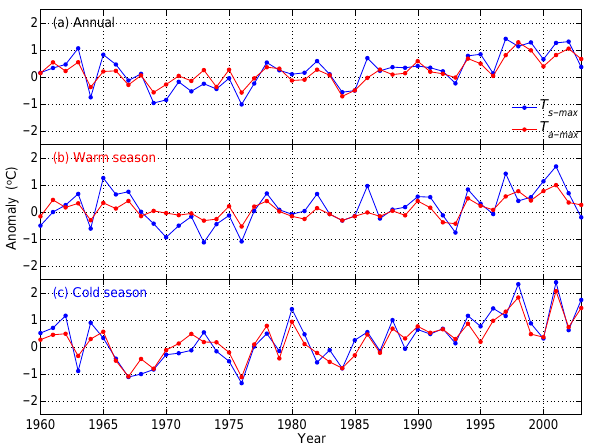
Figure 3. National mean yearly anomalies of daily minimum land surface temperature ( T s-min , blue line) and daily minimum air tem- perature ( T a-min , red line) for the annual (a) , warm (b) , and cold (c) seasonal scales for the reference period